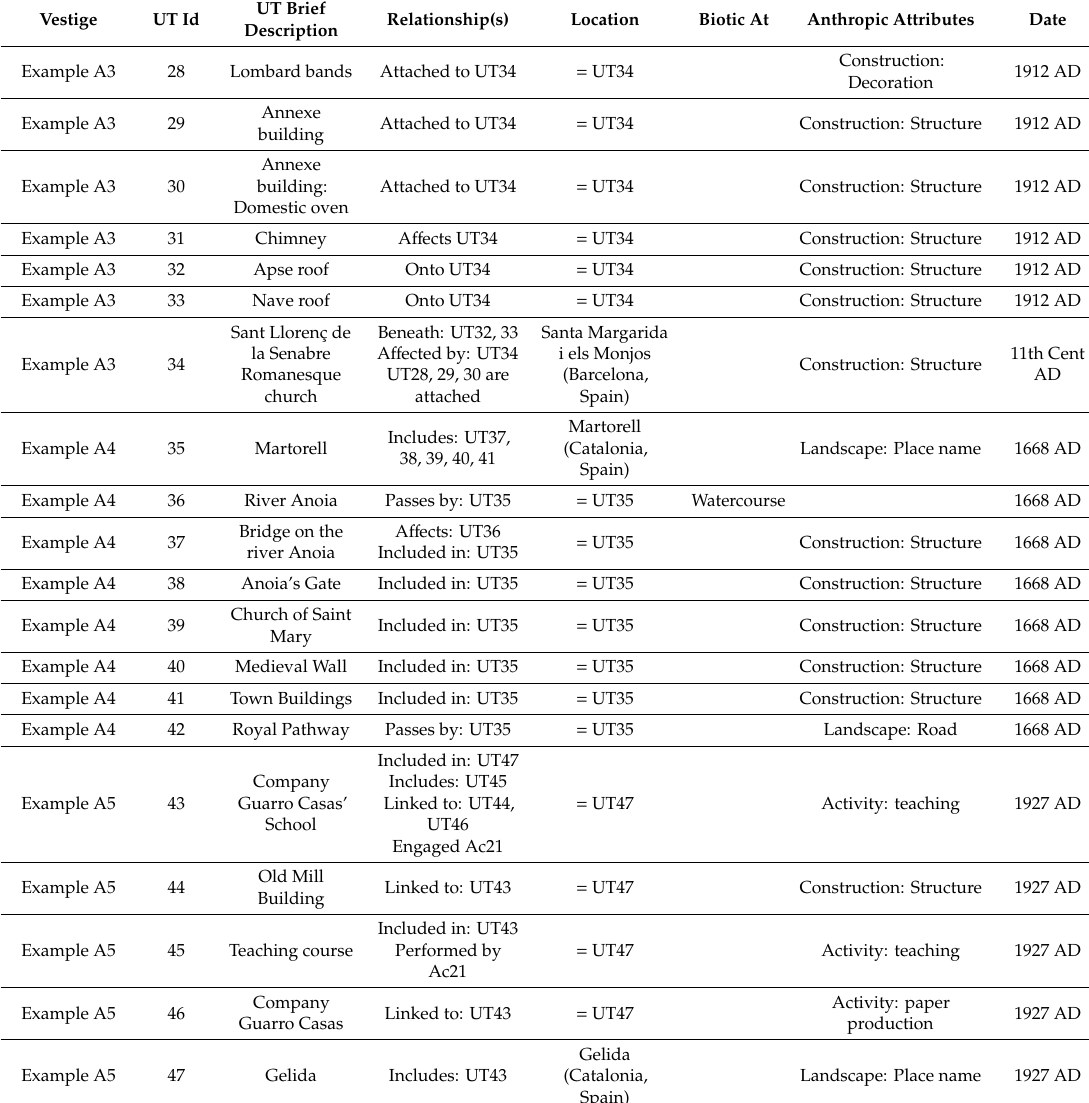
Table A4. Simplified UT dataset gathered from Examples A3, A4, and A5.